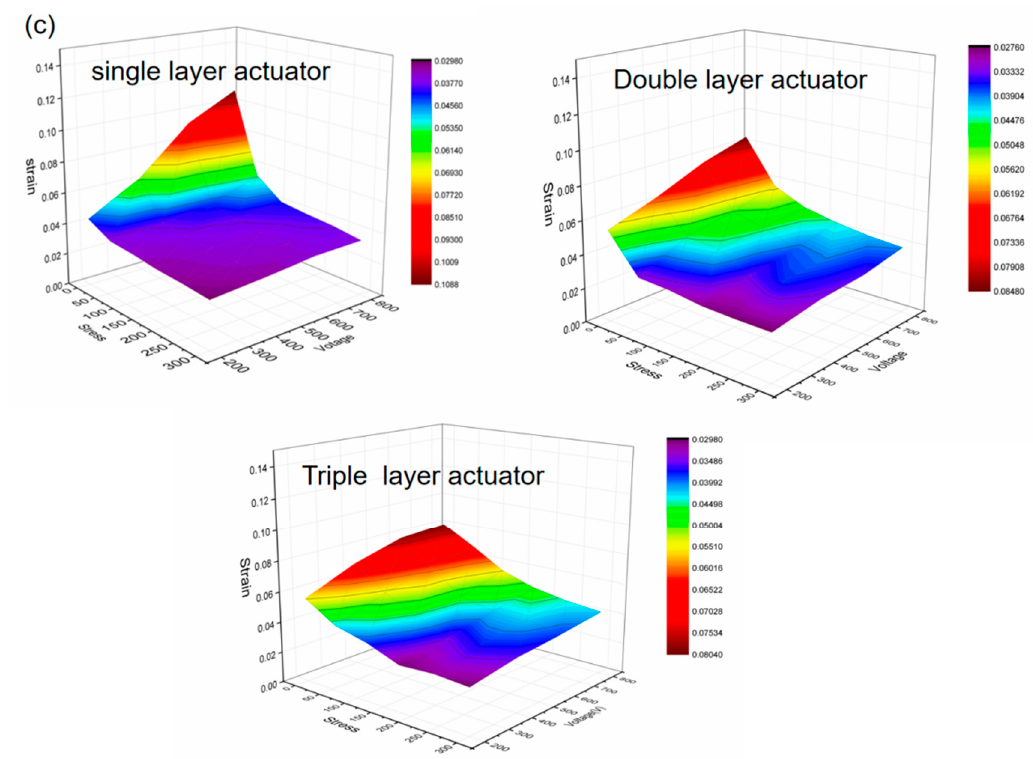
Figure 8. Performance of the printed structures. ( a ) The strain–span curves of metal electrode-based PVC gel actuators at different voltages. ( b ) The strain–voltage curves of the CNT/SMP composite electrode–based actuator and a metal electrode-based actuator with the same kind of core layer. ( c ) The strain–stress curves of the PVC gel actuators with different numbers of layers under voltage from 200 V to 800 V.